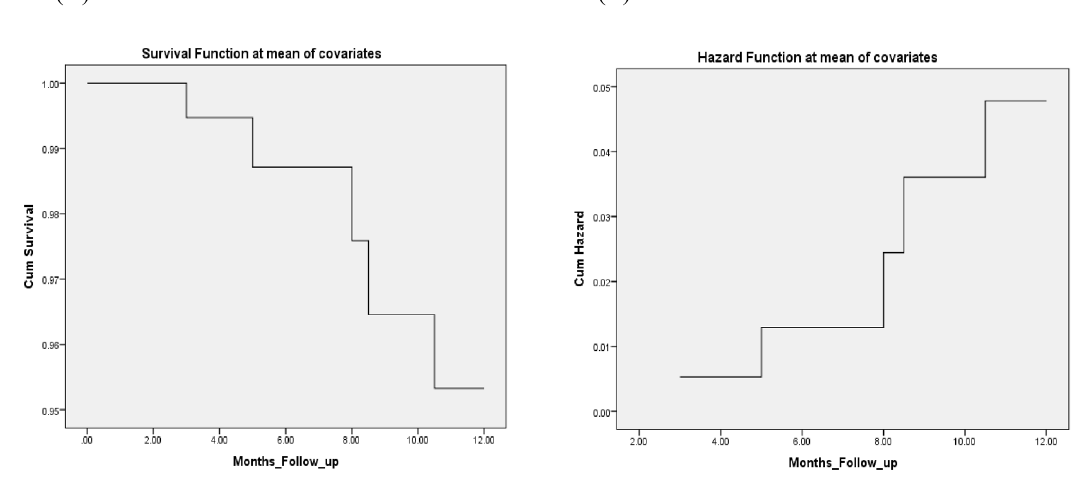
Figure 5. Cox regression curves for cumulative survival and hazard associated with elevated Hs-cTn mean value of 19.27. ( A ) Cumulative survival rate for Hs-Trops in acute heart failure. ( B ) Cumulative hazard rate Hs-Trops in acute heart